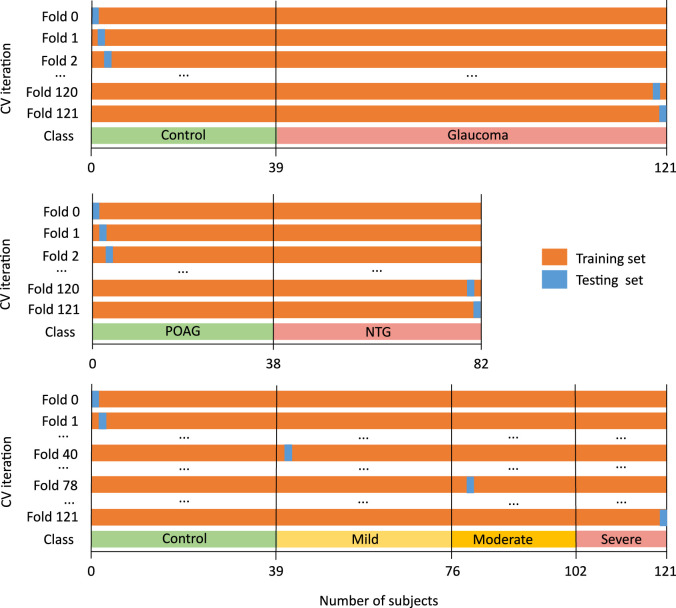
Leave-one-out cross-validation for differentiating glaucoma patients from controls (first row), distinguishing POAG and NTG types of glaucoma (second row), and identifying glaucoma severity levels (third row).